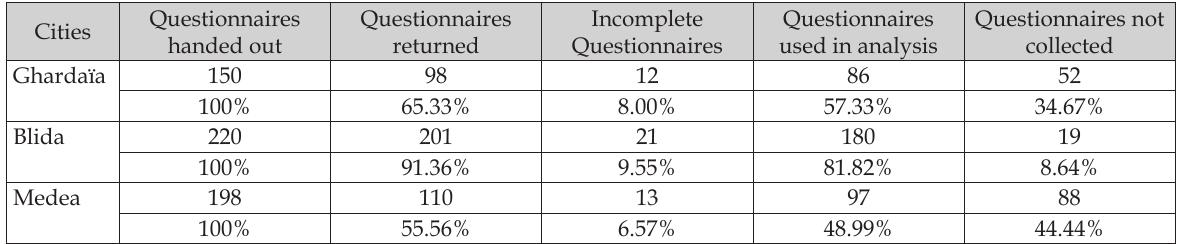
Table B. Handling of the